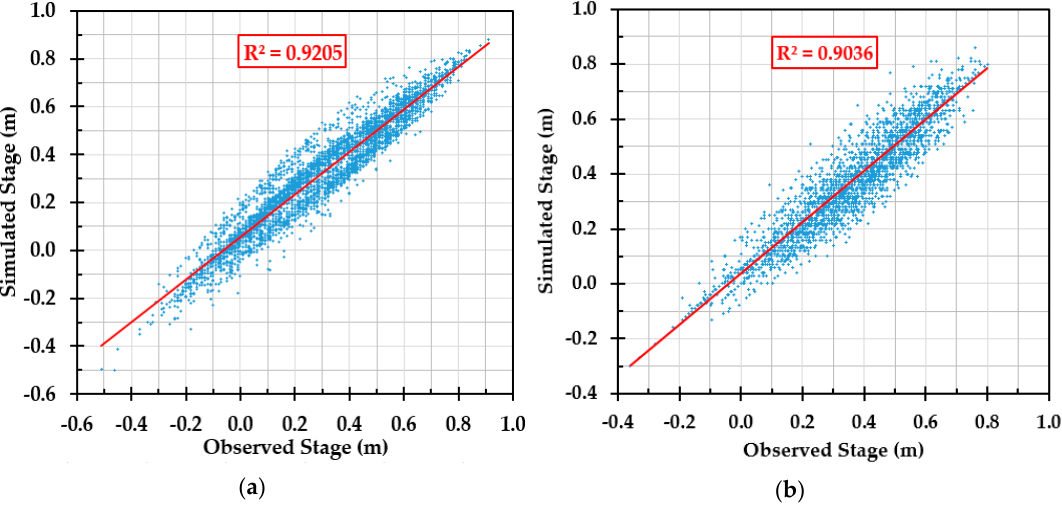
Figure 14. Model calibration comparison between computed and observed stages for the chosen Manning’s values at ( a ) station number 3.2 and ( b ) station number 55.